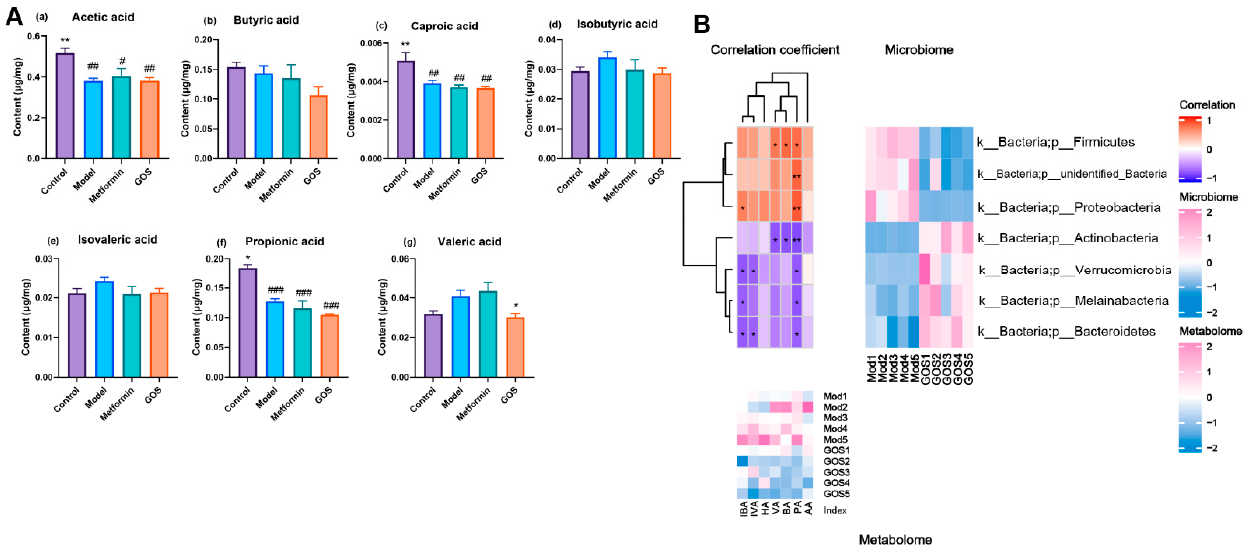
Figure 11. ( A ) Changes of SCFAs in the cecum content of mice in each group. Note: * p < 0.05, ** p < 0.01 vs. the model group; # p < 0.05, ## p < 0.01, ### p < 0.001 vs. the control group ( n = 4–5, mean ± SEM). ( B ) Heat map of Spearman correlation at the phylum level. The strength of the color represents the degree of association. The heatmap shows the Spearman correlation between different microorganisms and different metabolites. The abscissa represents metabolites, the ordinate represents microorganisms, * represents a p value of < 0.05 in the correlation coefficient significance test, and ** represents a p value < 0.01. The abundance data of microorganisms and metabolites were standardized using Z scores.